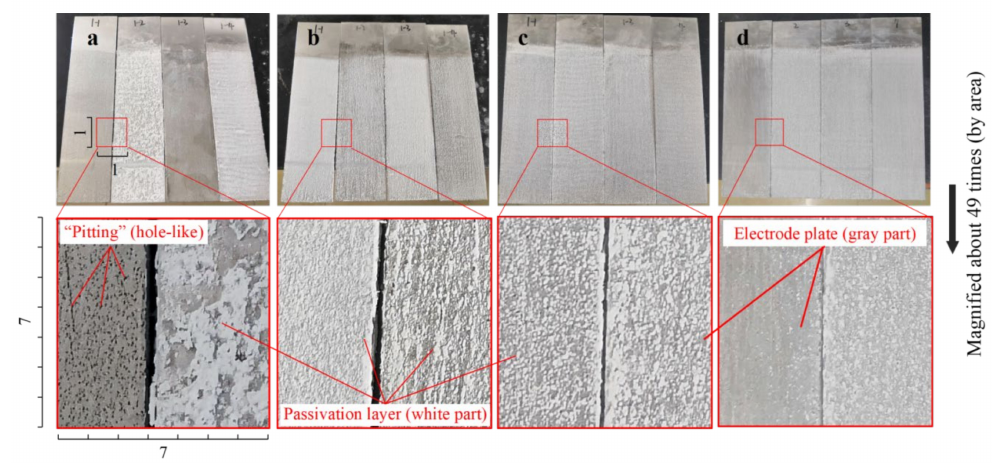
Figure 3. The surface of the electrodes after operating the EC − filtration system for 90 min under